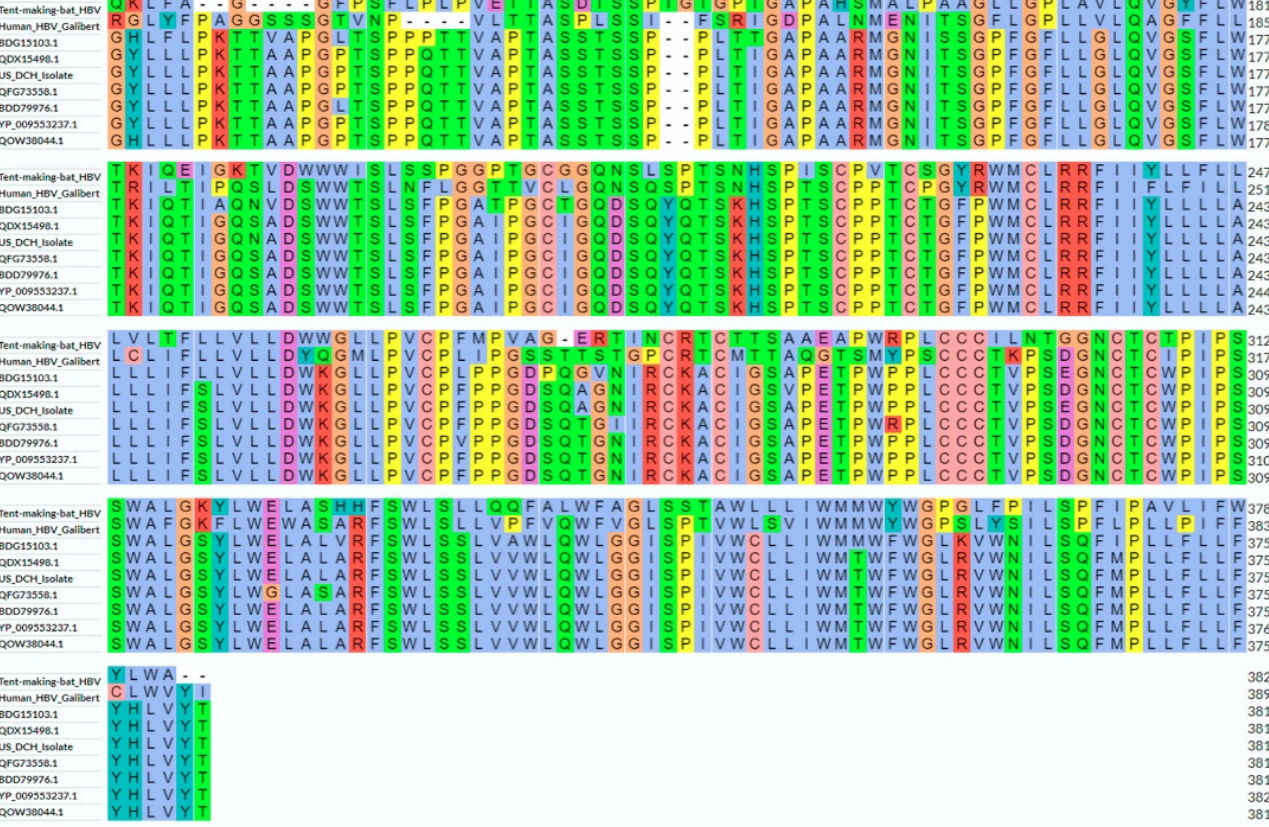
Figure 5. Sequence alignment of the whole large surface protein sequence of DCH isolates, human HBV, and tent-making bat HBV. Red rectangle represents the highly conserved domain necessary for NTCP binding. BDG15103.1 = Japan isolate 1 (Rara); YP_009553237.1 = Sydney isolate; BDD79976.1 = Japan isolate 2; QOW38044.1 = Thailand isolate; QFG73558.1 = Malaysia isolate; QDX15498.1 = Italy isolate. Analysis and figure generated using Uniprot Align [23].